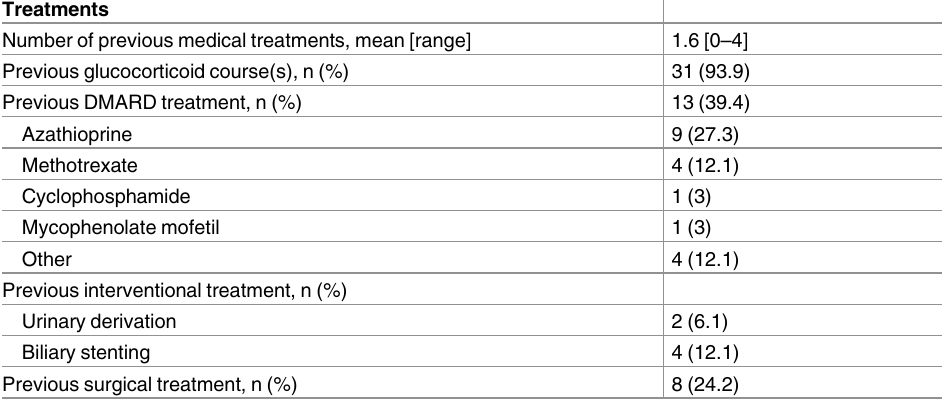
Table 2. Previous treatments receivedfor IgG4-RD prior to RTX in 33 patients with IgG4-RD treated with RTX.